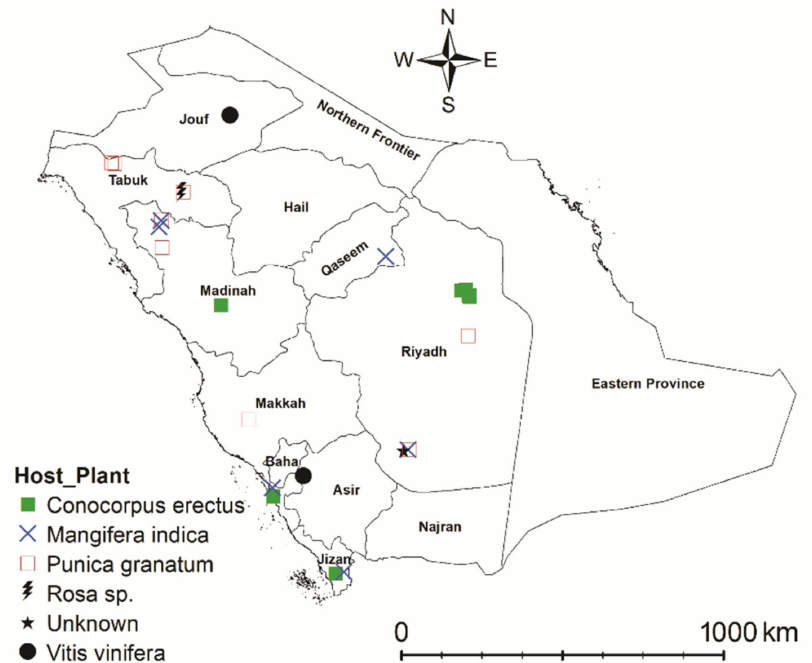
Figure 2. Geographical distribution of Oligonychus punicae in Saudi Arabia, reported on six host plants ( Conocorpus erectus , Mangifera indica , Punica granatum , Rosa sp., Unknown & Vitis vinifera ) and collected from 26 localities of eight provinces (Asir, Jouf, Jizan, Makkah, Madinah, Qassim, Riyadh, & Tabuk) (ARCGIS 10.5., esri.com computer software, Esri TM , Redlands, CA,